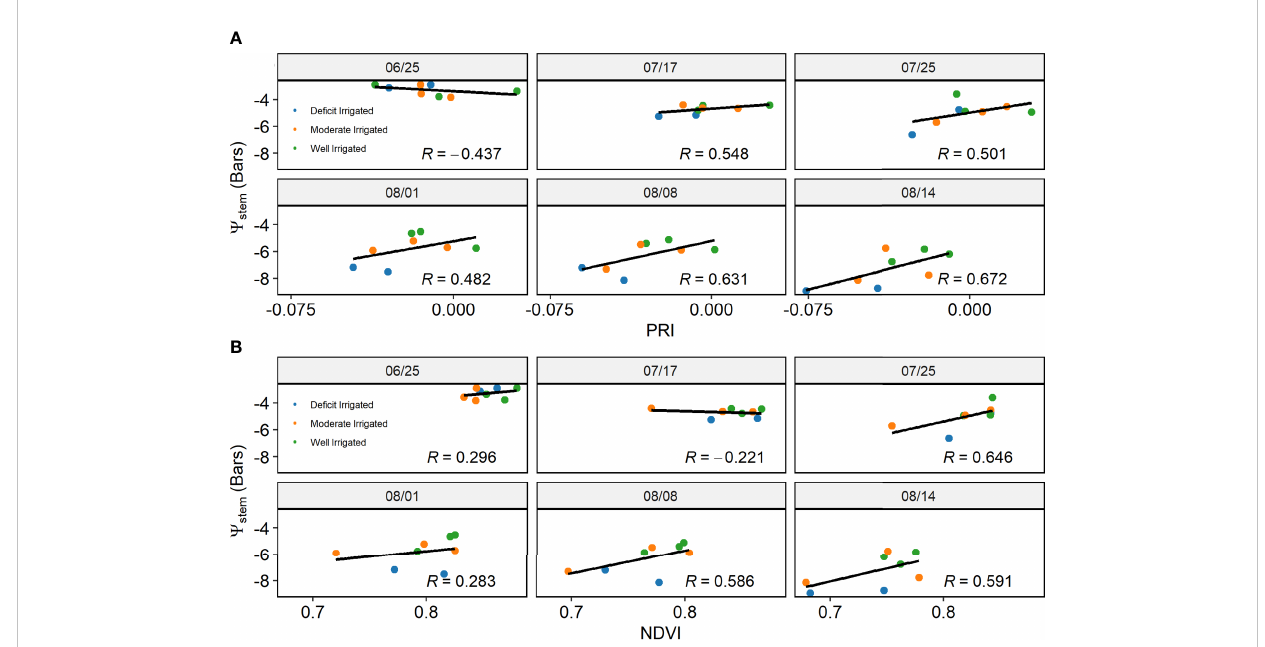
FIGURE 5 The correlation between (A) photochemical re fl ectance index and (B) normalized difference vegetation index from proximal sensors and ground measured stem water potential ( y stem ) for each individual